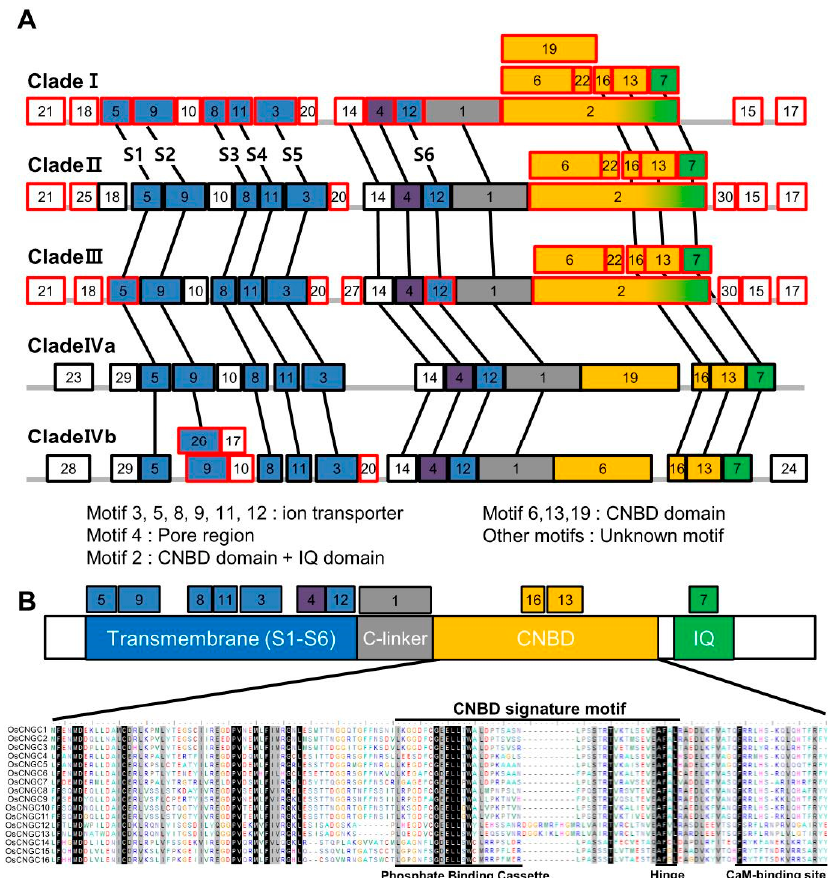
Figure 2. ( A ) MEME domain analysis and schematic diagram for main motif structures of five CNGC gene pairs from five CNGC subfamilies, respectively, in rice and Arabidopsis. The red and black squares borders represent non- and conservative MEME domains in the subfamily; their accumulation positions are the location of the corresponding amino acid positions. Motifs with known functions are marked in distinct colors (blue, purple, gray, yellow, orange, and green). Other colorless boxes indicate unknown motif. The known function domains were obtained from the SMART and PFAM tools. ( B ) Structural diagram of conserved MEME motifs in all CNGC proteins of rice and Arabidopsis. The transmembrane region, c-linker, CNBD domain, CaMBD domain, and IQ domain are represented by several rectangles with the colors of blue, gray, yellow, orange, and green, re- spectively. Below is the alignment of the CNBD domains of 16 CNGCs. It can be suggested that members of clade I have emerged as a genetic basis for evo- lution to form CNGC subfamilies in different directions. Similar to clade I, CNGCs in clades II and III underwent partial differentiation at the same location. However, the N- terminals and C-terminals from clades IVa and IVb have unique motifs, such as motifs 23, 28, 29, and 24, which do not exist in clades I, II, and III. In case of clade Ⅳ a, the CNBD domain was finally differentiated as to have motifs 19, 16, and13 and in case of clade Ⅳ b,